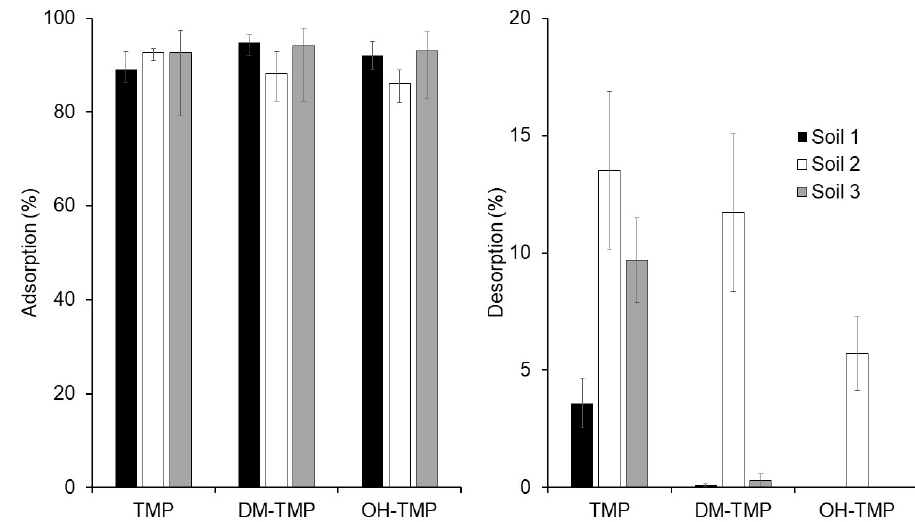
Figure 4. Adsorption and desorption percentage of TMP and its metabolites in three different soils.